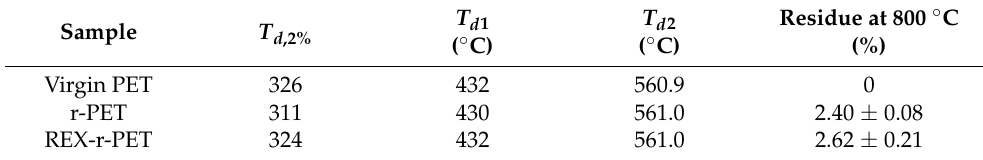
Table 2. Thermal parameters obtained by DTGA.